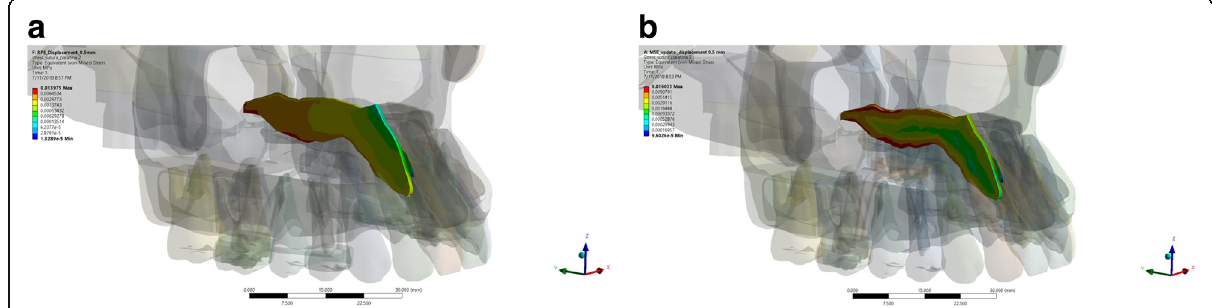
Fig. 3 The von Mises stress distribution of the palatine suture in the expansion simulation using ( a ) RME, and ( b )